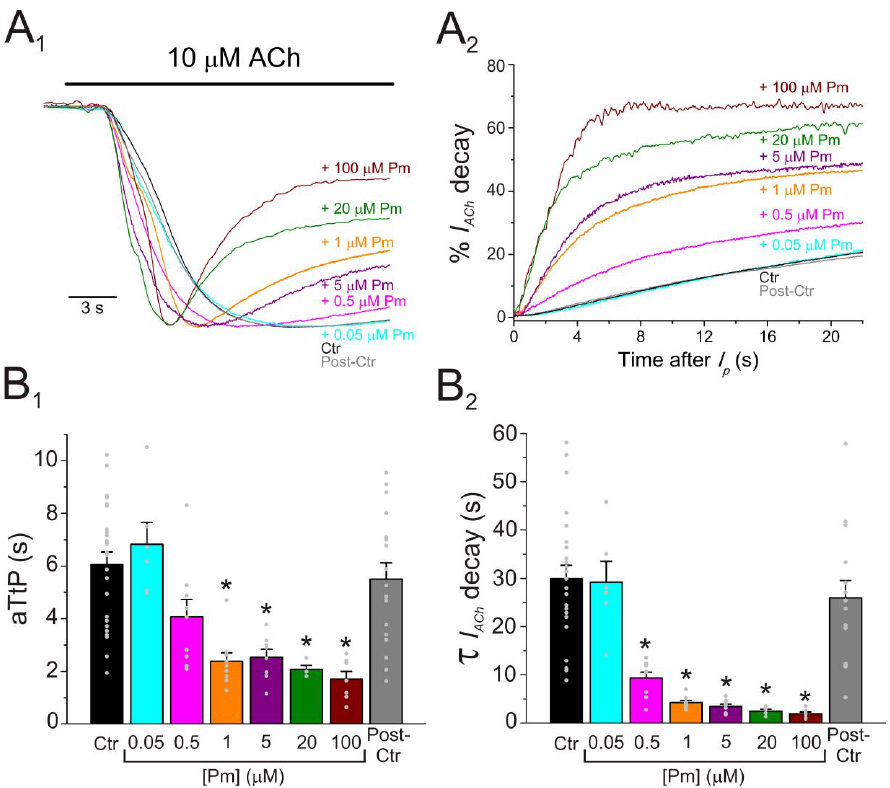
Fig.3 Figure 3. Pm accelerates I ACh decay and shortens the time to reach I p . ( A 1 ,A 2 ) Superimposed I ACh s elicited by 10 µ M ACh either alone (black and grey recordings) or together with different Pm concentrations (shown at right). I ACh s were scaled to the same I p amplitude to better compare the differences in time to reach I p (aTtP; A 1 ) and kinetics of I ACh decay after I p ( A 2 ). ( B 1 , B 2 ) Column graphs displaying Pm effects on aTtP ( B 1 ) and τ -values of I ACh - decay ( B 2 ). (*) indicates significant differences among I ACh s in presence of Pm (colored columns; same color code as in ( A 1 , A 2 )) and their control values (Ctr, black column; p < 0.05, ANOVA and Bonferroni t -test). Note that post-control values (after Pm applications; grey column) were similar to control ones. Each point is the average of 4–24 cells ( N =